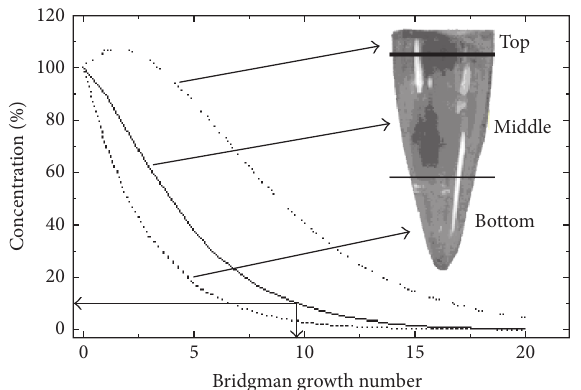
Figure 5: Predictive concentration (%) for Salt 1 as a function of repetition number of Bridgman growth, curves calculated from the model of Figure 1 and (7), (8), and (9). To achieve 10% of initial concentration in the crystal middle region, approximately 10 steps are required.